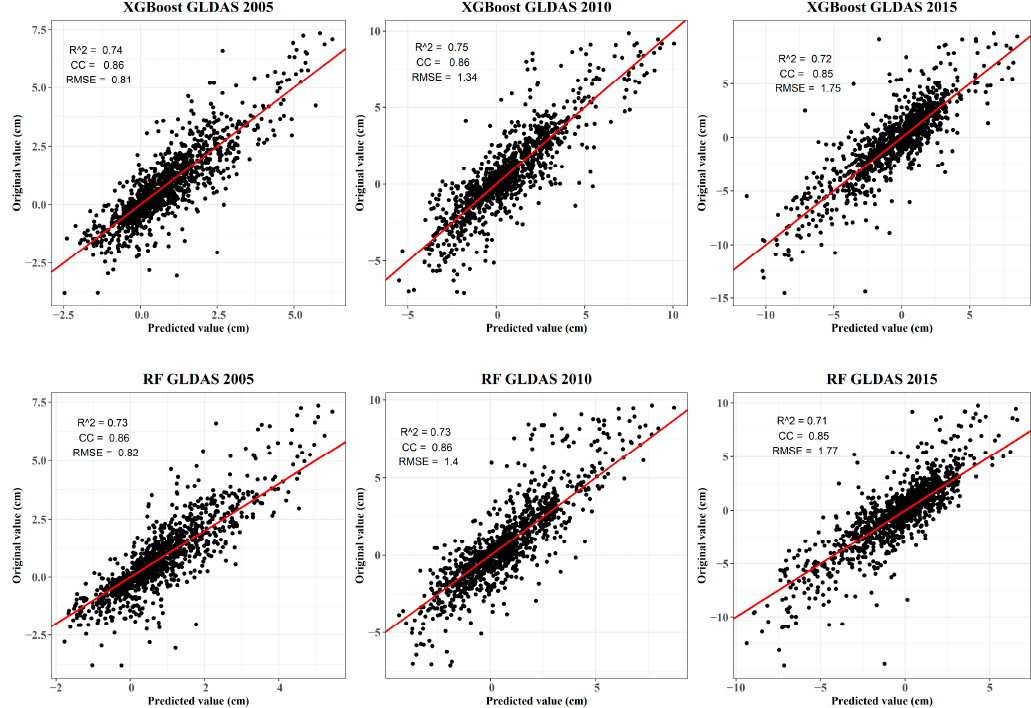
Figure 6. Scatterplots and regression fits of the testing dataset of GLDAS using XGBoost and RF and the original dataset for 2005, 2010 and 2015.